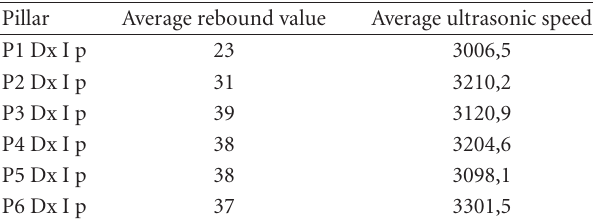
Table 6: Right side pillar (Dx): First